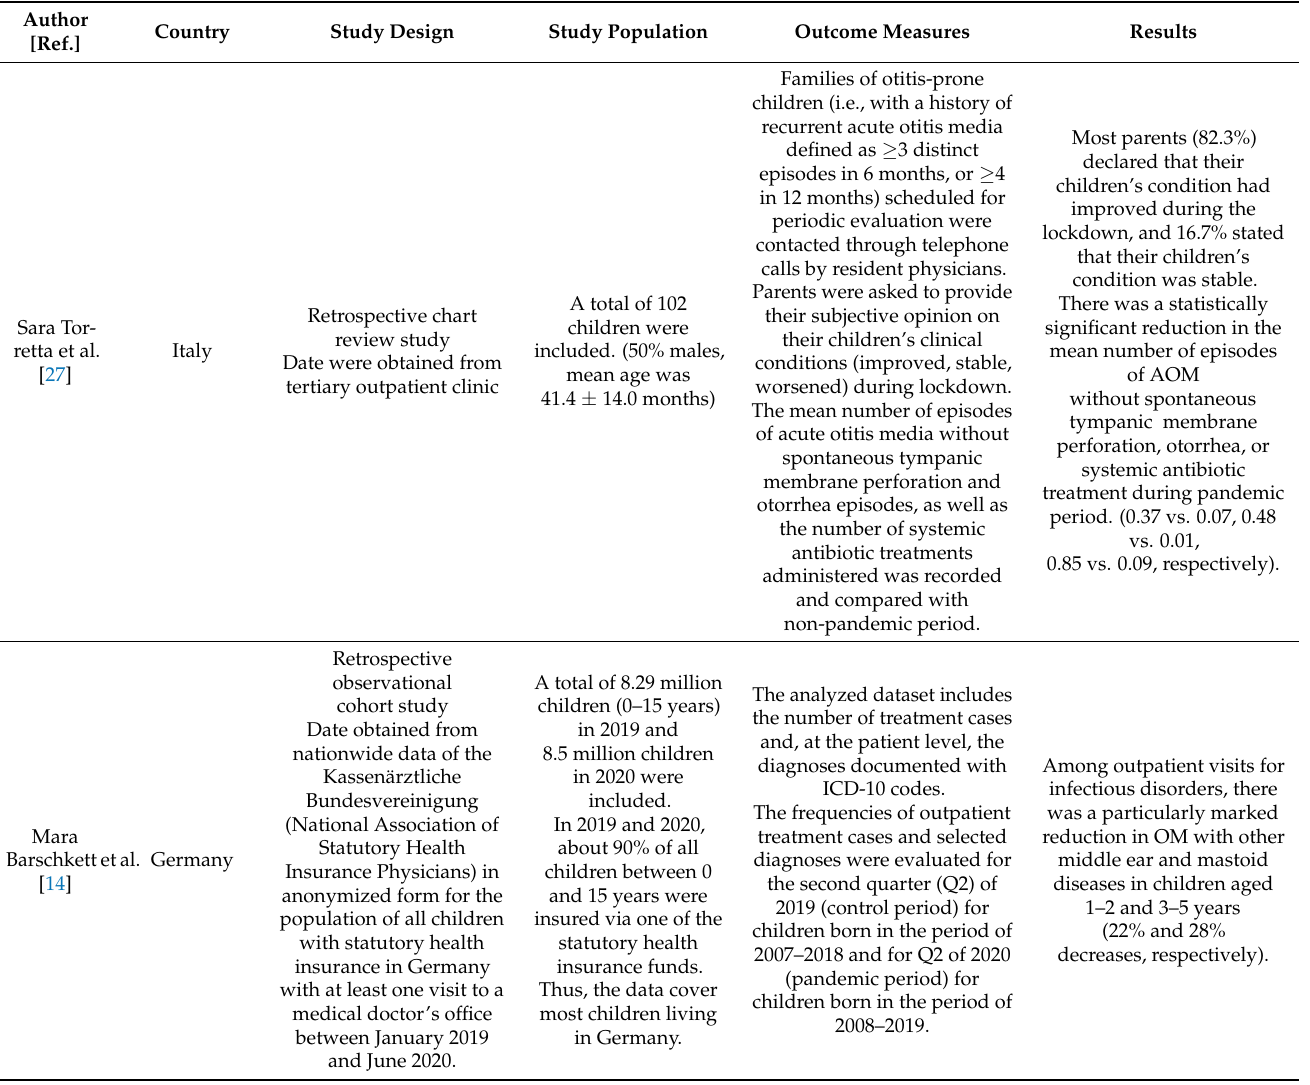
Table 5. Summary of studies on complications of OM during the COVID-19